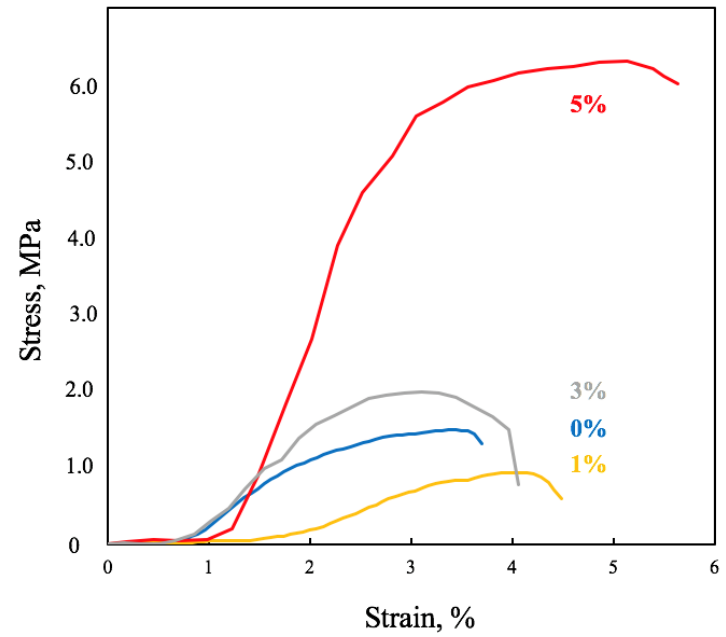
Figure 3. Typical tensile stress-strain curves of electrospun materials based on PHB with different content of Hmi: 0% wt. ( blue ), 1% wt. ( yellow ), 3% wt., ( grey ) and 5% wt. ( red ).